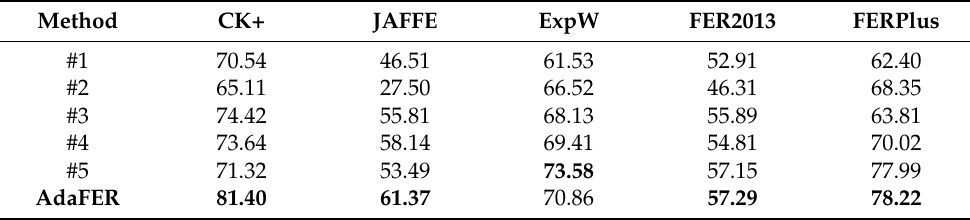
Table 1. Performance (%) comparison between the proposed AdaFER and baseline methods. RAF-DB is used as source